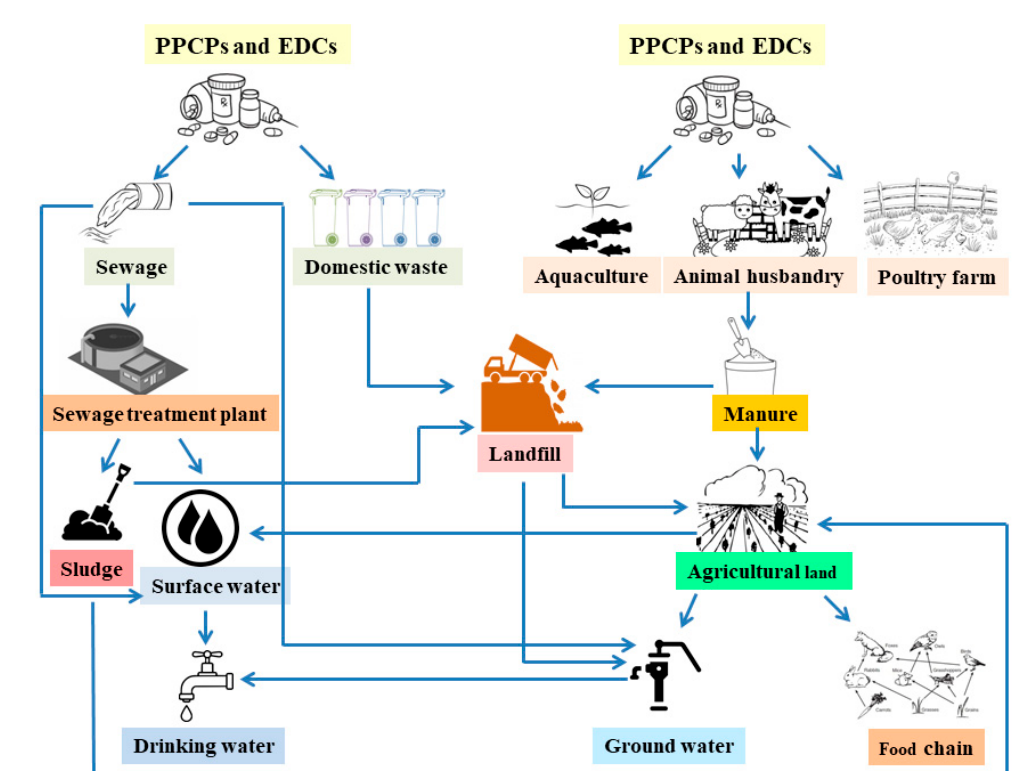
Figure 3. Flow diagram showing the possible pathway for the pharmaceutical and personal care products (PPCPs) and endocrine-disrupting chemicals (EDCs) to enter into landfill sites from different sources (domestic waste, animal husbandry, aquaculture, poultry farm, and sewage) and contaminate the different environmental compartments, such as drinking water, groundwater, agricultural soil, and the food chain.